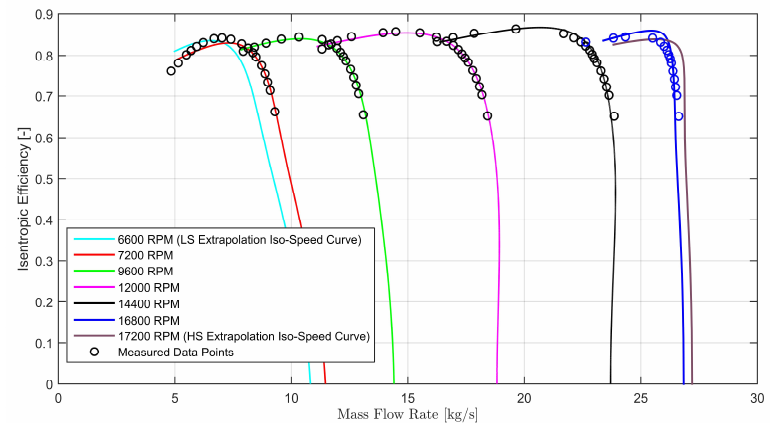
Figure 9. Prediction and extrapolation result of the zonal compressor isentropic efficiency model.